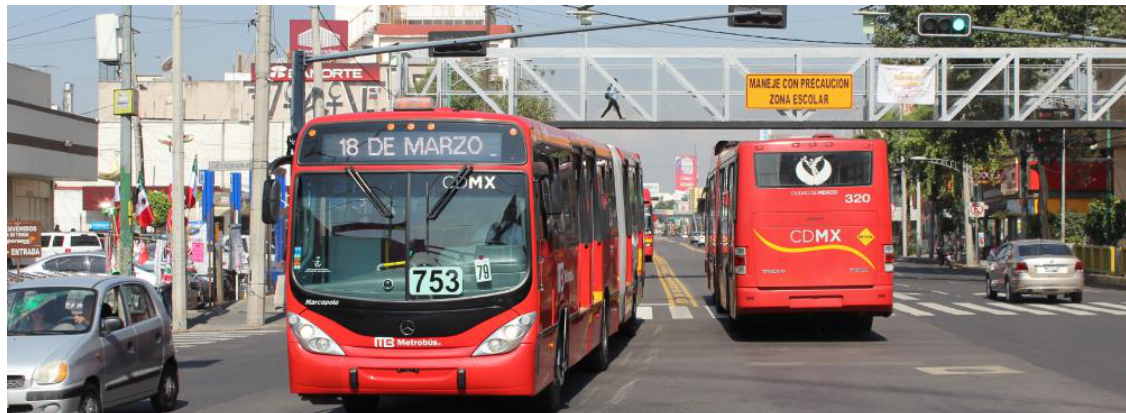
Figure 1. Line 6 Metrobus. Reprinted with permission from Ref. [12].